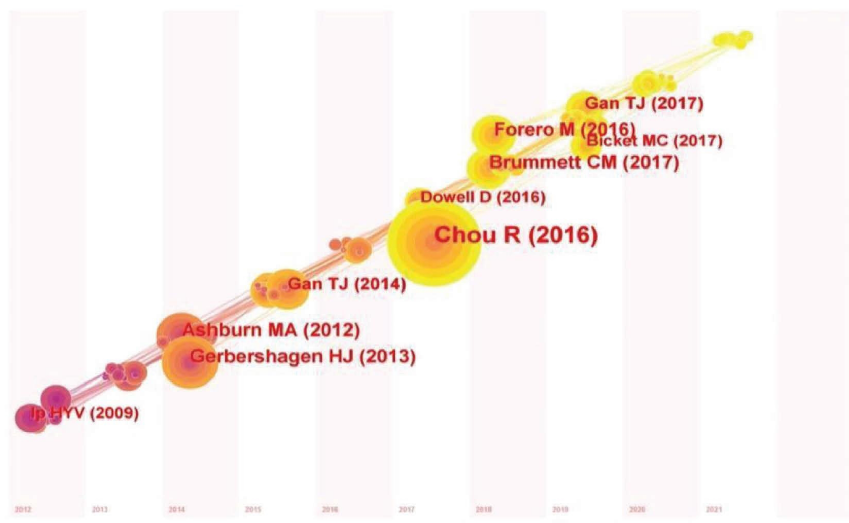
Figure 8: Time-zone depiction of cocited publications on acute postsurgical pain, 2012–2021.